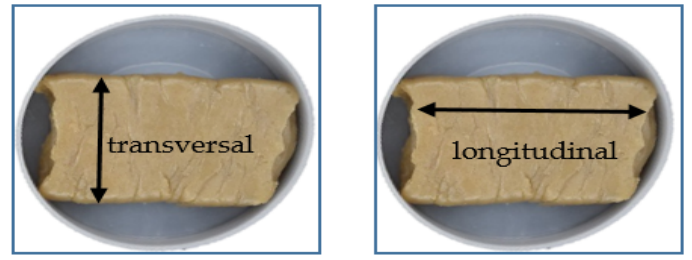
Figure 3. Transversal and longitudinal cutting directions of samples.